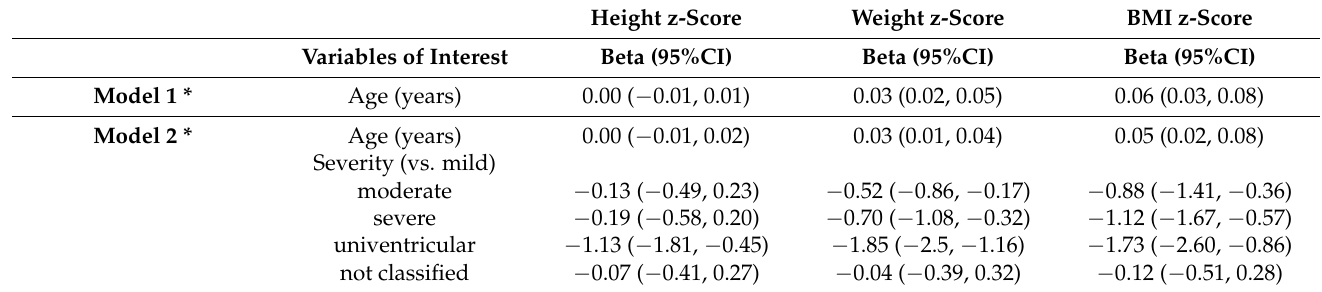
Table 2. Associations of age and CHD severity with height, weight, and BMI